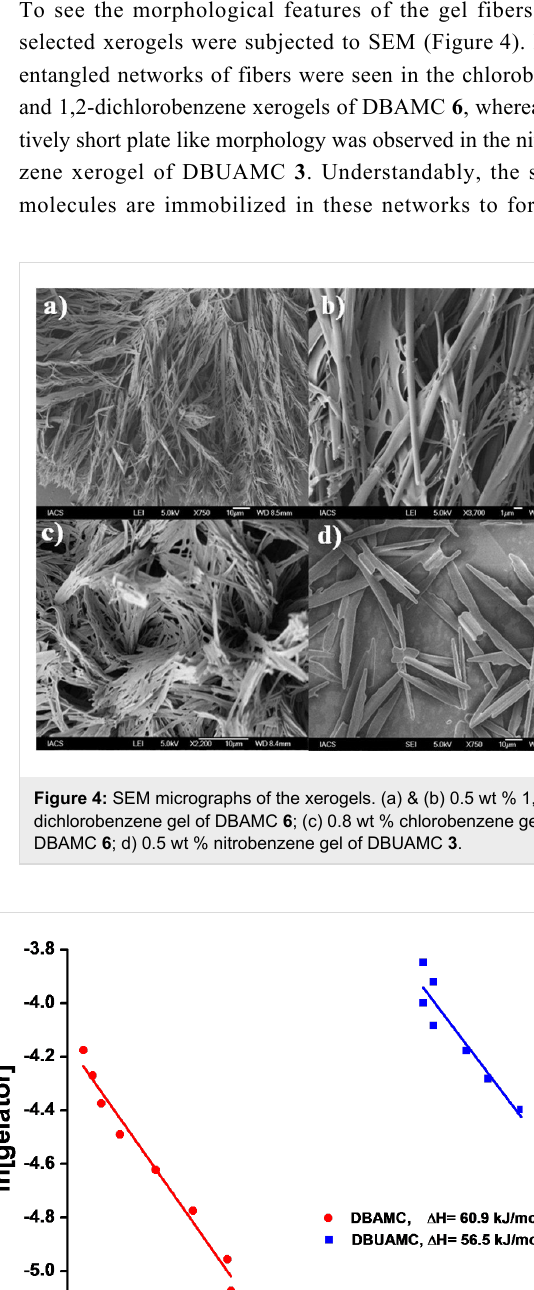
Figure 3: Left – T gel vs [gelator] plot; right – semilog plot of mole fraction of the gelators against 1/ T ; 1,2-Dichlorobenzene and nitrobenzene gels were used for DBAMC 6 and DBUAMC 3 , respectively.